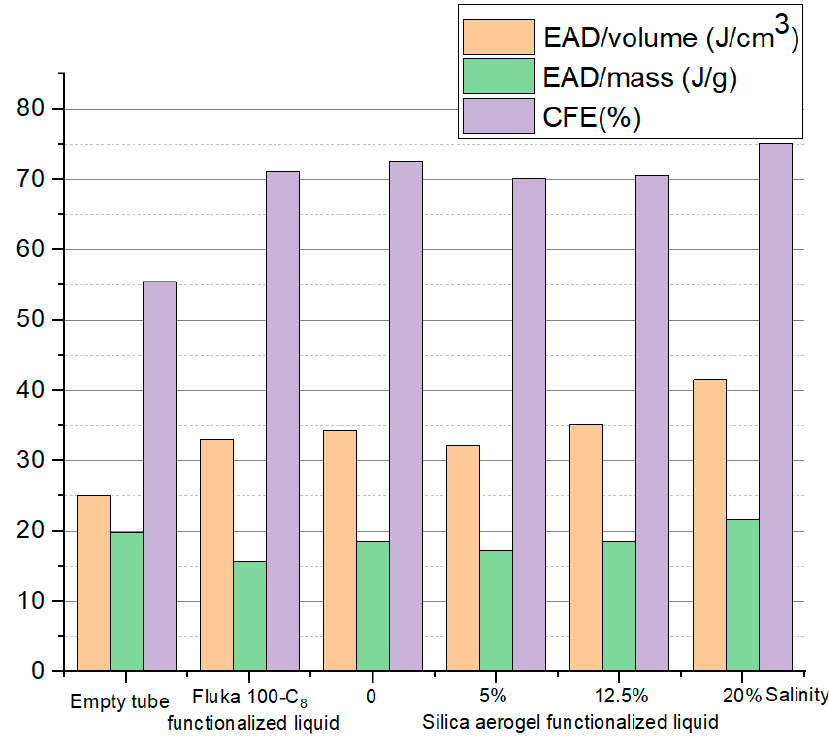
Figure 13. Simulated energy-absorption capabilities with different salinities.